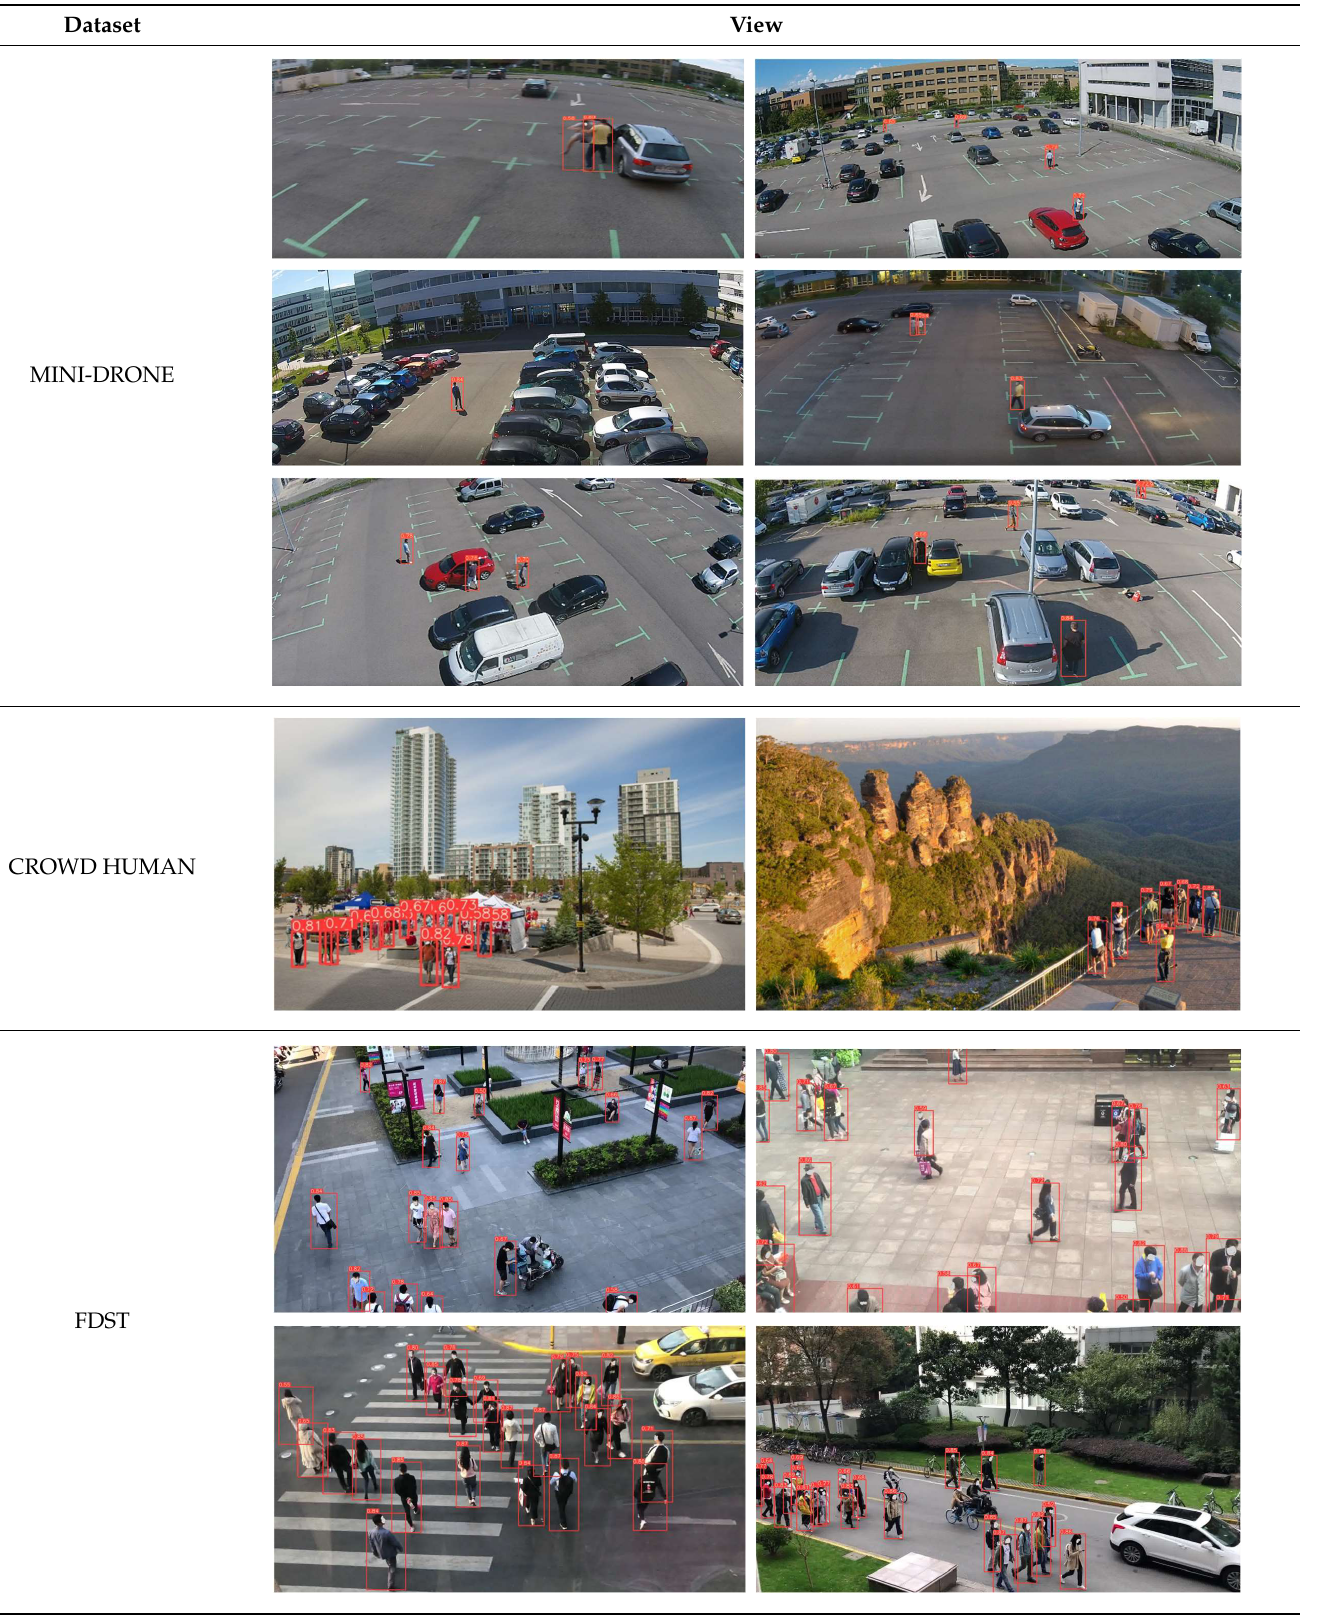
Table 7. Qualitative person detection results per selected videos/images via the custom YOLOv5s.